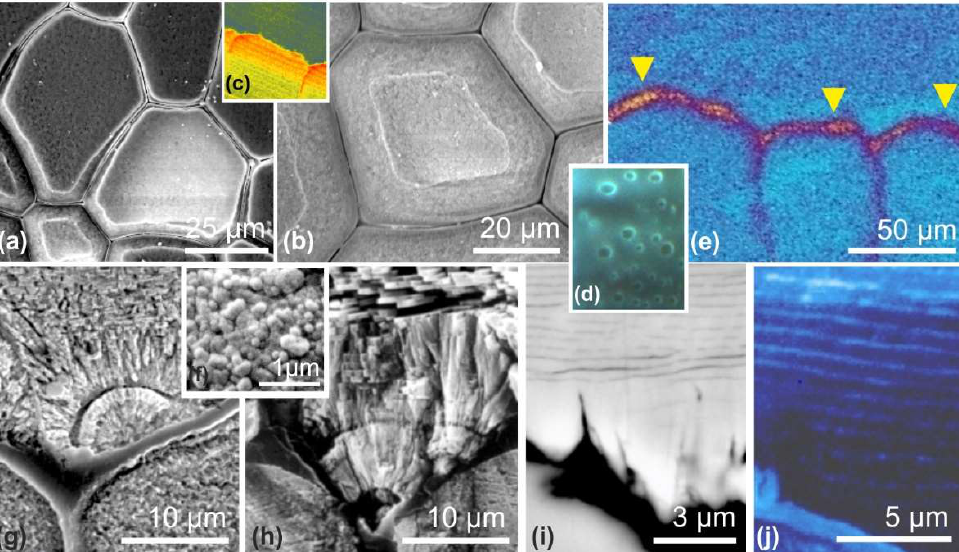
Figure 8. Pinctada : structural and biochemical changes during the major transitional phase in shell formation: occurrence of aragonite in a pre-nacreous phase. ( a , b ) Regression of the mineralizing membranes at the top of the prisms in the terminal growth phase. ( c ) Biochemical changes in the composition of the mineralizing layers (XANES mapping). ( d ) Holes in the prism envelopes (UV fluorescence). ( e ) Patchy aspect and specific composition of the organic (glycine) deposition onto the final surface of the prisms (TOF-SIMS mapping); note the difference from the prism envelopes. ( f ) Granular structure of early aragonite deposition on the organic membrane covering the prisms. ( g , h ) Spherulitic crystallization of aragonite on the initial aragonite deposition. ( i , j ) Progressive occurrence of nacreous membranes viewed in SEM backscattered mode and ( i ) NanoSIMS ( j ). Credit pictures: (c,j)[26], (e) [27].